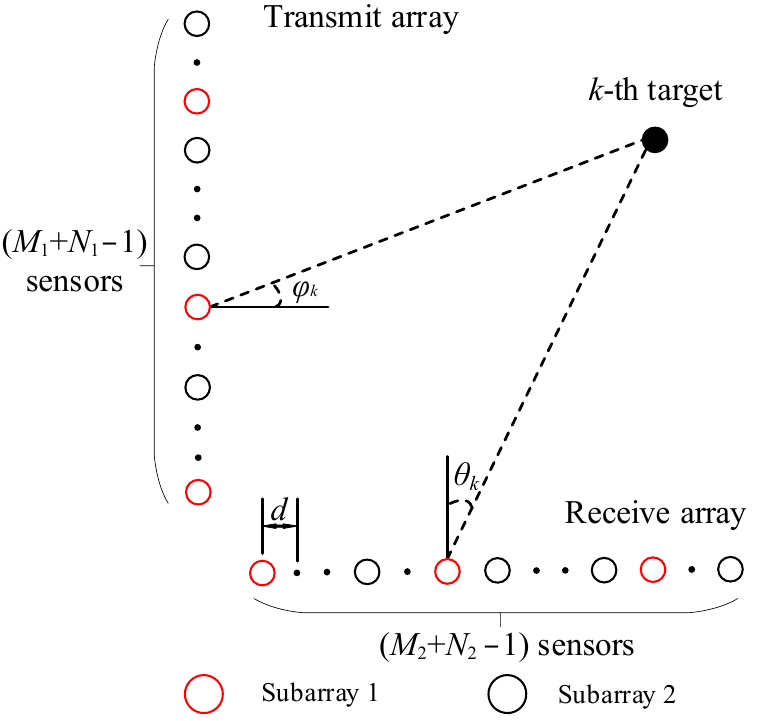
Figure 1. Bistatic coprime array MIMO radar model.